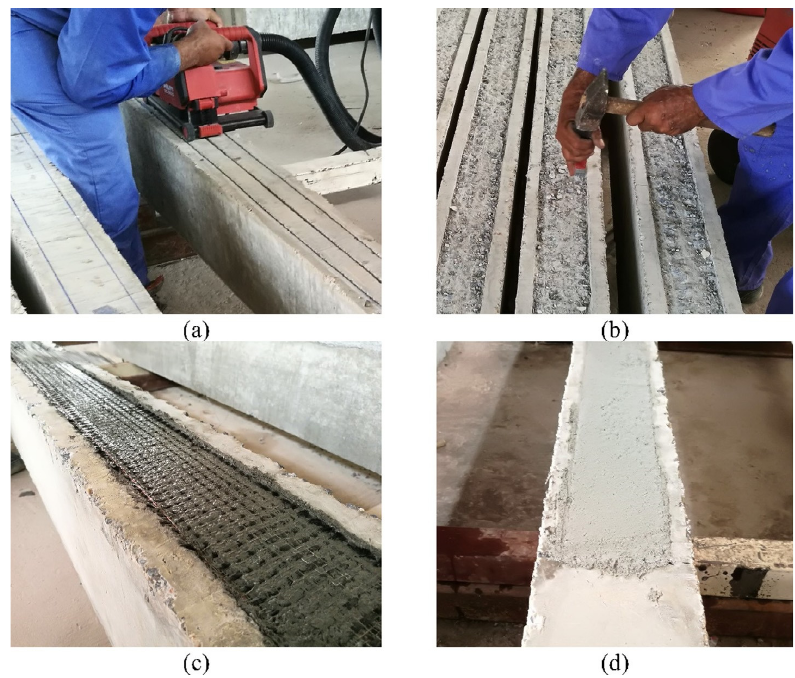
Figure 18. FRCM strengthening process: ( a ) grooving the beam, ( b ) chipping the concrete and clearing the groove, ( c ) applying first layer of mortar and impregnating the fabric, ( d ) finishing after FRCM application. Reproduced with permission from [39], Elsevier, 2019.